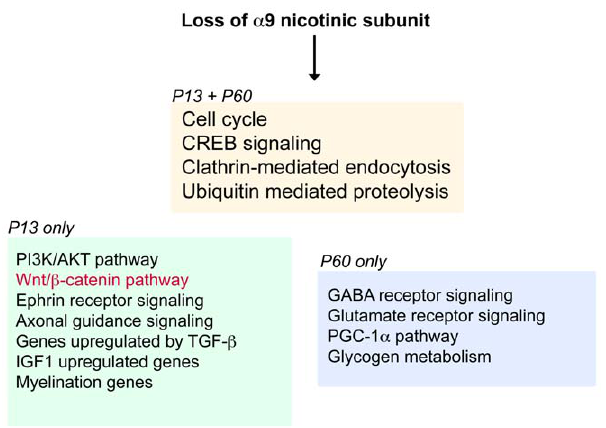
Figure 8. Summary of over-represented gene categories. Several functional categories, based on PANTHER annotations and GSEA results, are significantly perturbed upon loss of a 9 nicotinic subunit at postnatal time periods P13 and P60. While several processes are common to both ages (orange box), others are preferentially expressed at P13 (green box) or P60 (blue box). Only Wnt/ b -catenin pathway (highlighted in red) is identified as over-represented in a 9 2 / 2 by both PANTHER and GSEA analyses.